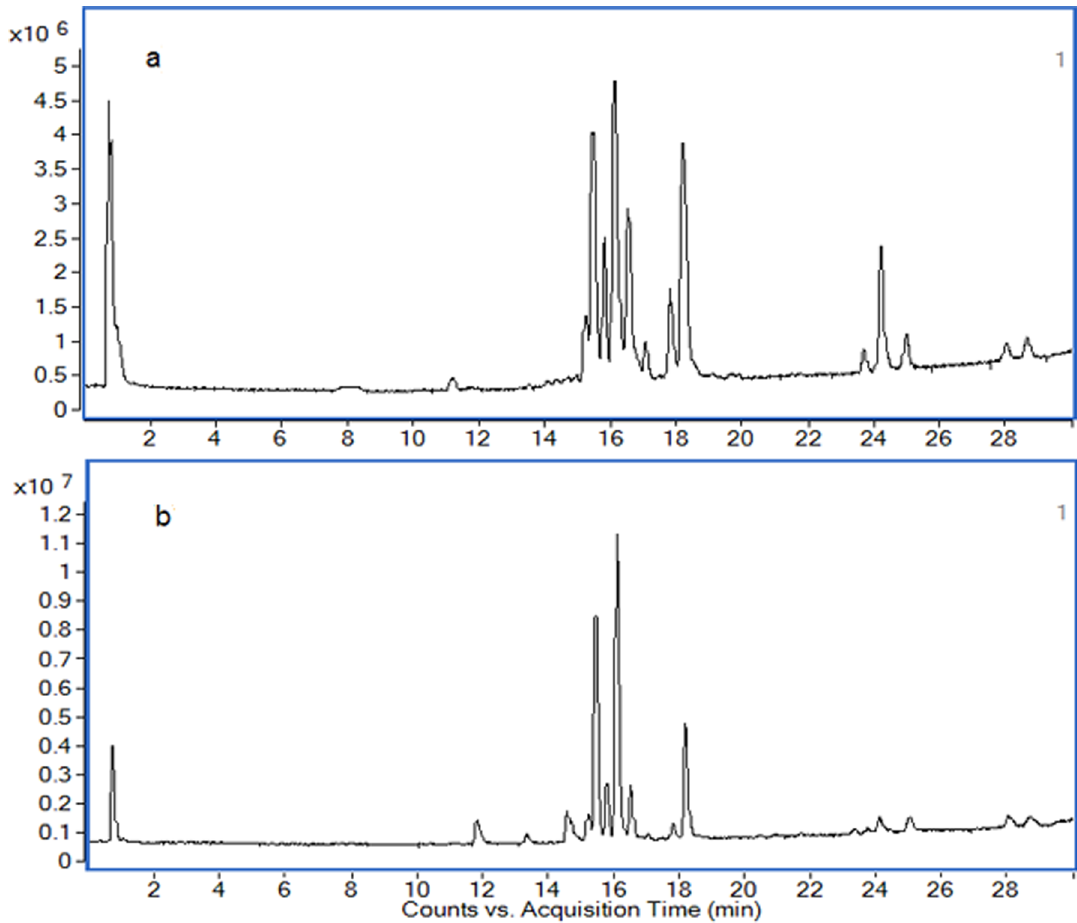
Figure 2. Typical TIC chromatograms for serum obtained in the positive ion mode (a) and negative ion mode (b).